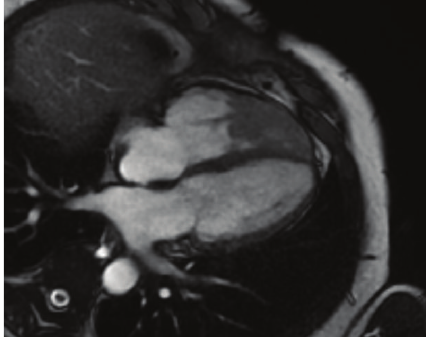
Figure 4: Cardiac MRI showing RV mass. On MRI, the mass was found to involve the apex and mid right ventricle. Ejection fraction on the left ventricle was estimated to 60%. There was also noted turbulence over the aortic valve, suggestive of a possible mass.